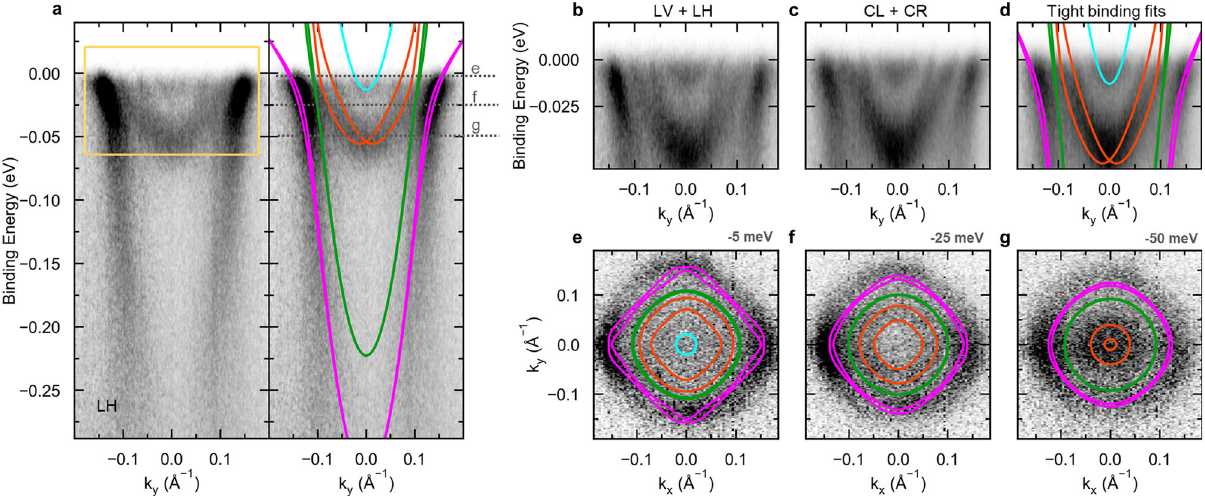
Fig. 1 | Electronic band structure of KTO(001) 2DEGs. a Band dispersion of Al/ KTO(001) surface measured by ARPES. The electrons are collected at normal emis- sionwithlinearlypolarizedphotonsat31eV( Γ 002 ofbulkKTO).Thetight-binding fi ts areoverlaidtothedataintherightpanel.Aspeci fi ccolorisassociatedtoeachpairof bands. The yellow box highlights the energy range in panels b – d . b ( c ) Sum of